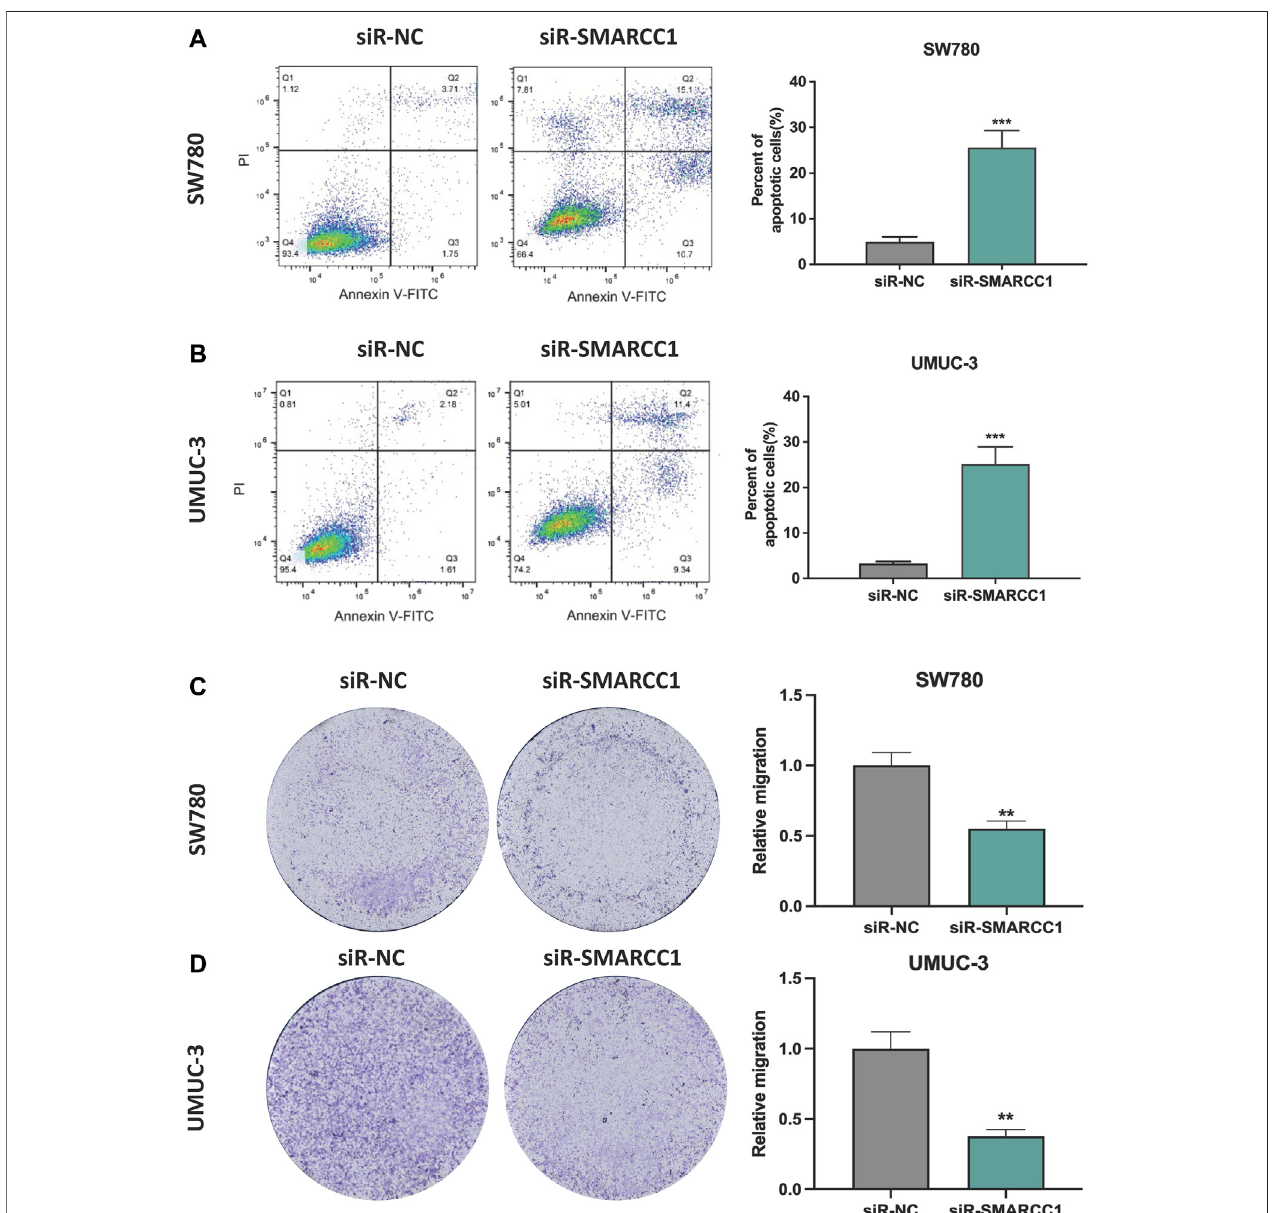
FIGURE 5 | Silencing SMARCC1 induced cell apoptosis and suppressed cell migration of BC. (A – B) Flow cytometry analysis was performed to determine the apoptosis rate of cells. Knockdown of SMARCC1 expression markedly increased the number of apoptotic cells in both SW780 and UMUC-3 cell lines. (C – D)